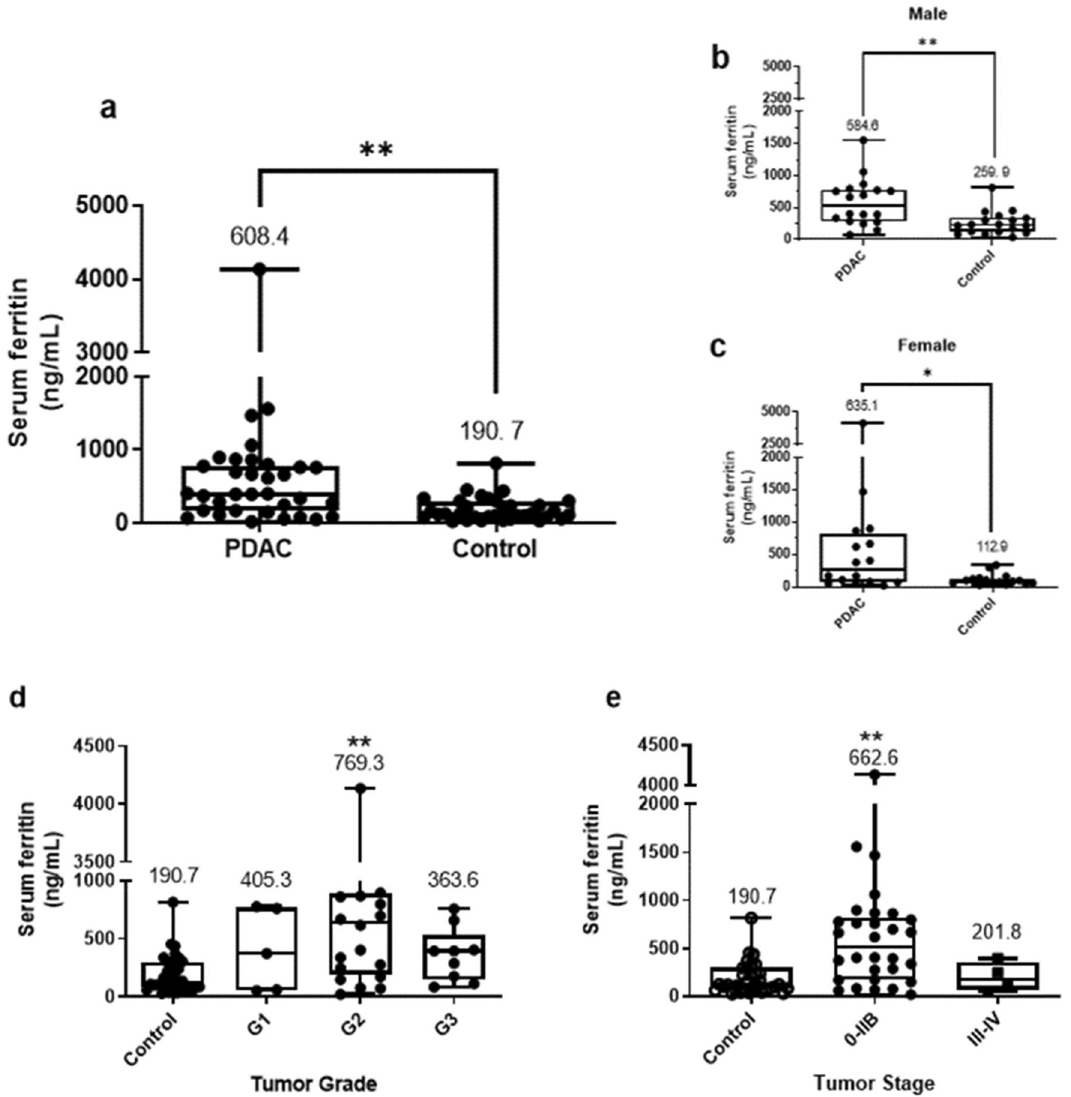
Figure 2. Association of serum ferritin (SF) with pancreatic cancer risks in Taiwan. ( a ) Levels of SF in pancreatic ductal adenocarcinoma (PDAC) patients (n = 34) and healthy controls (n = 34). ( b , c ) Serum levels of ferritin sub-grouped by gender. * p < 0.05 and ** p < 0.01 compared to the controls as determined by Student’s t -test. SF for subjects with healthy controls and pancreatic cancer patients was classified according to their ( d ) histological grade: G1 (n = 5), G2 (n = 20), and G3 (n = 9), ( e ) tumor stage: stage 0–IIB (n = 30) and stage III–IV (n = 4). ** p < 0.01 compared to the controls as determined by one-way ANOVA with Tukey’s post-hoc